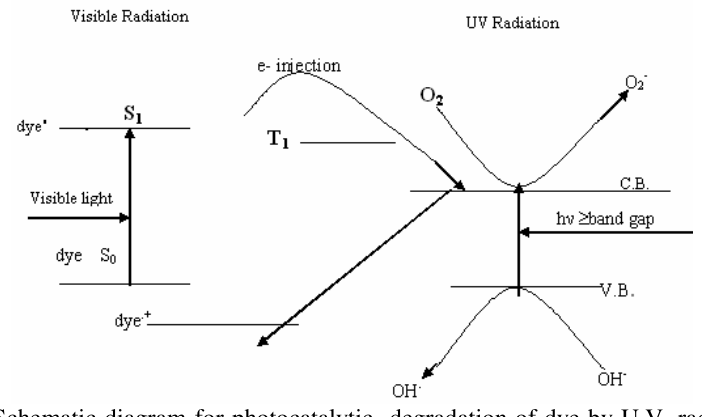
Figure 3. Schematic diagram for photocatalytic degradation of dye by U.V. radiation and/ or visible radiation